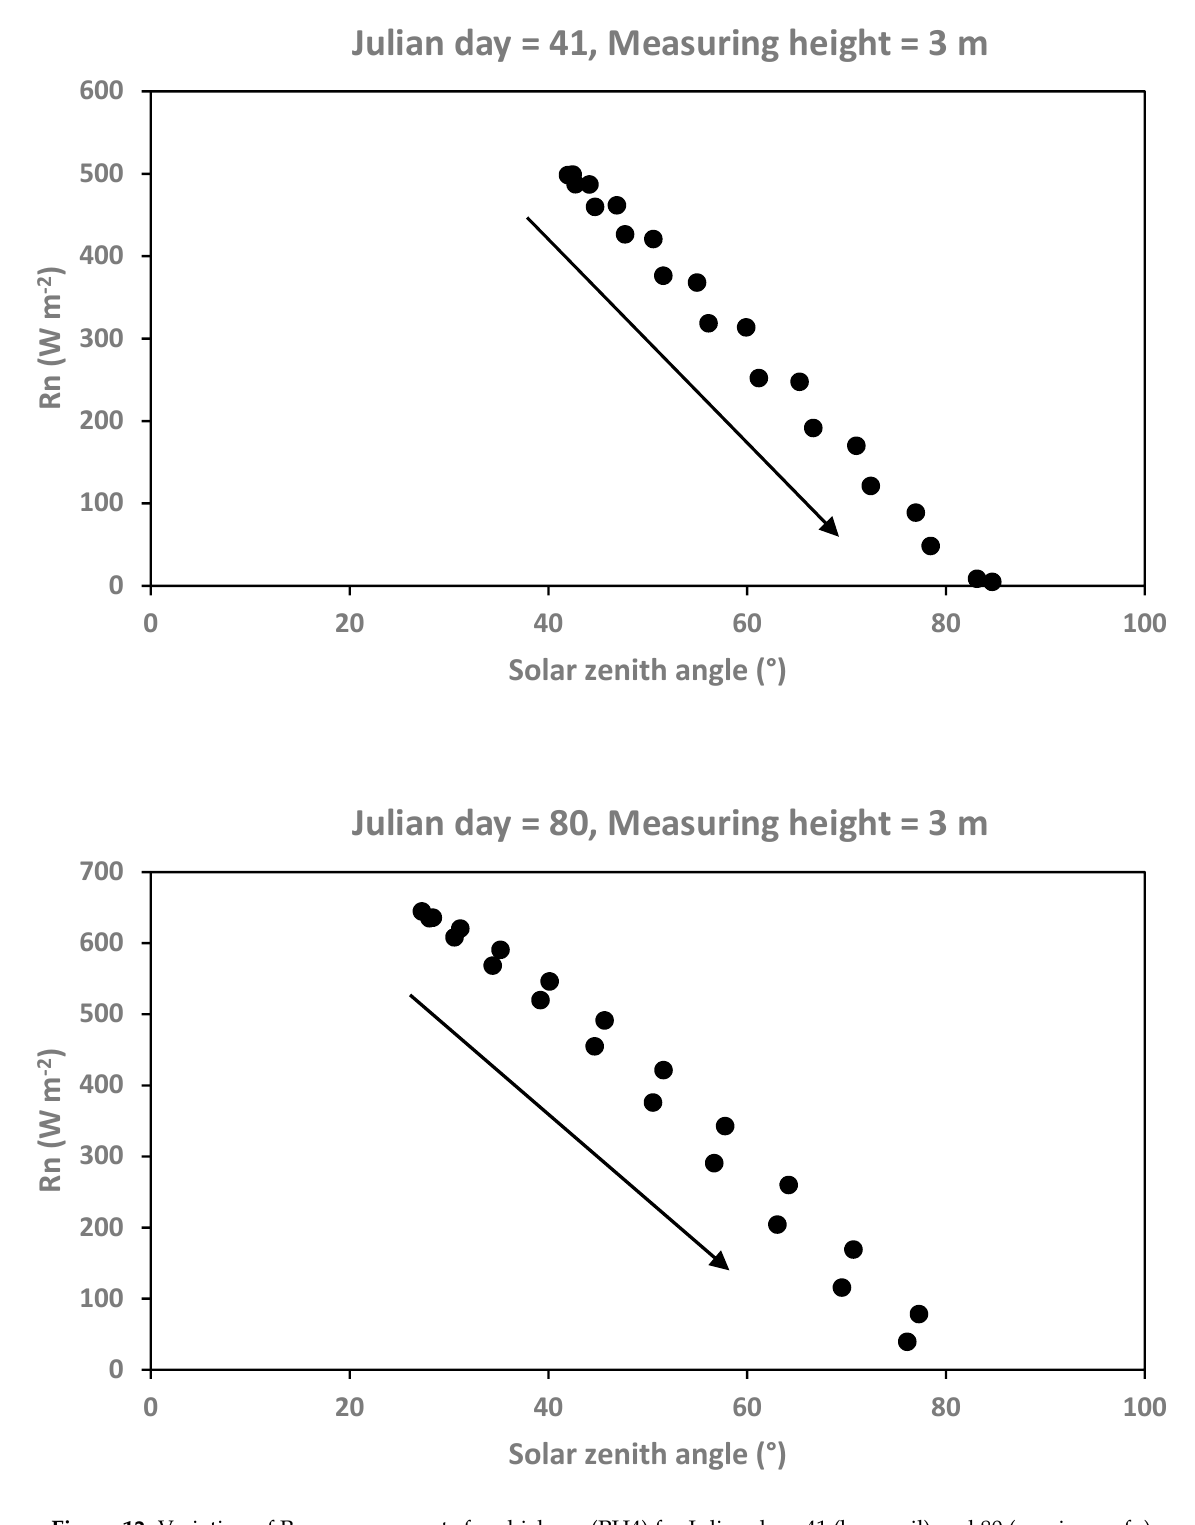
Figure 12. Variation of Rn measurements for chickpea (PH4) for Julian days 41 (bare soil) and 80 (maximum fv).